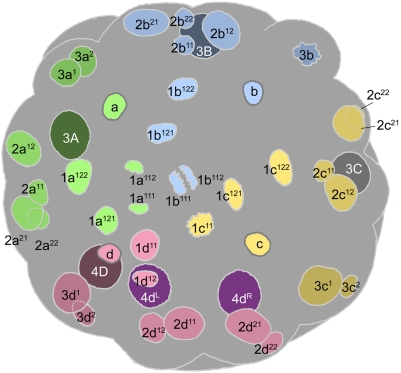
45-cell embryo, 540 minutes.The 1abc12 cells have finished dividing. Note the bilaterally symmetric arrangement of 1ac12 daughter cells. The 1abc11 cells are in slightly asynchronous mitoses. 3a has divided, and 3b is in metaphase.